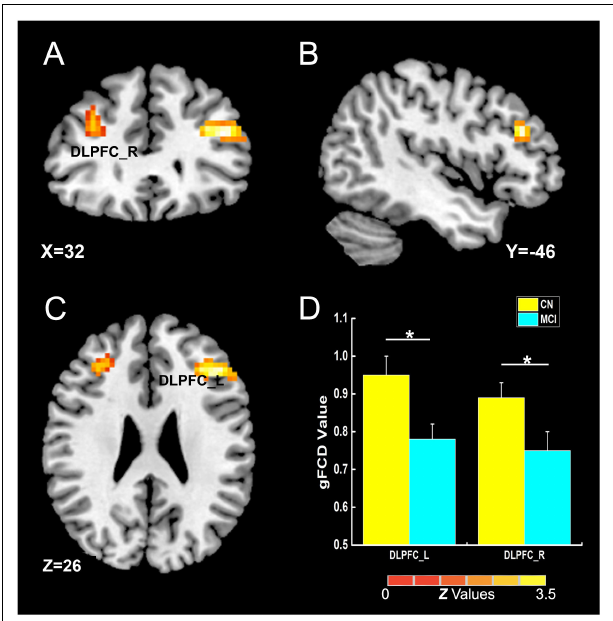
FIGURE 2 | The main influence of diagnosis on gFCD ( p < 0.005; α < 0.001; 3dClustSim corrected). (A–C) The brain regions show the differences in gFCD values between the two groups; (D) the histogram quantitatively illustrates that the values of gFCD in the bilateral DLPFC in the MCI group was lower than that in the CN group. The asterisks mean significant difference between two groups. gFCD, global functional connectivity density; CN, cognitively normal; MCI, mild cognitive impairment; DLPFC, dorsolateral prefrontal cortex.